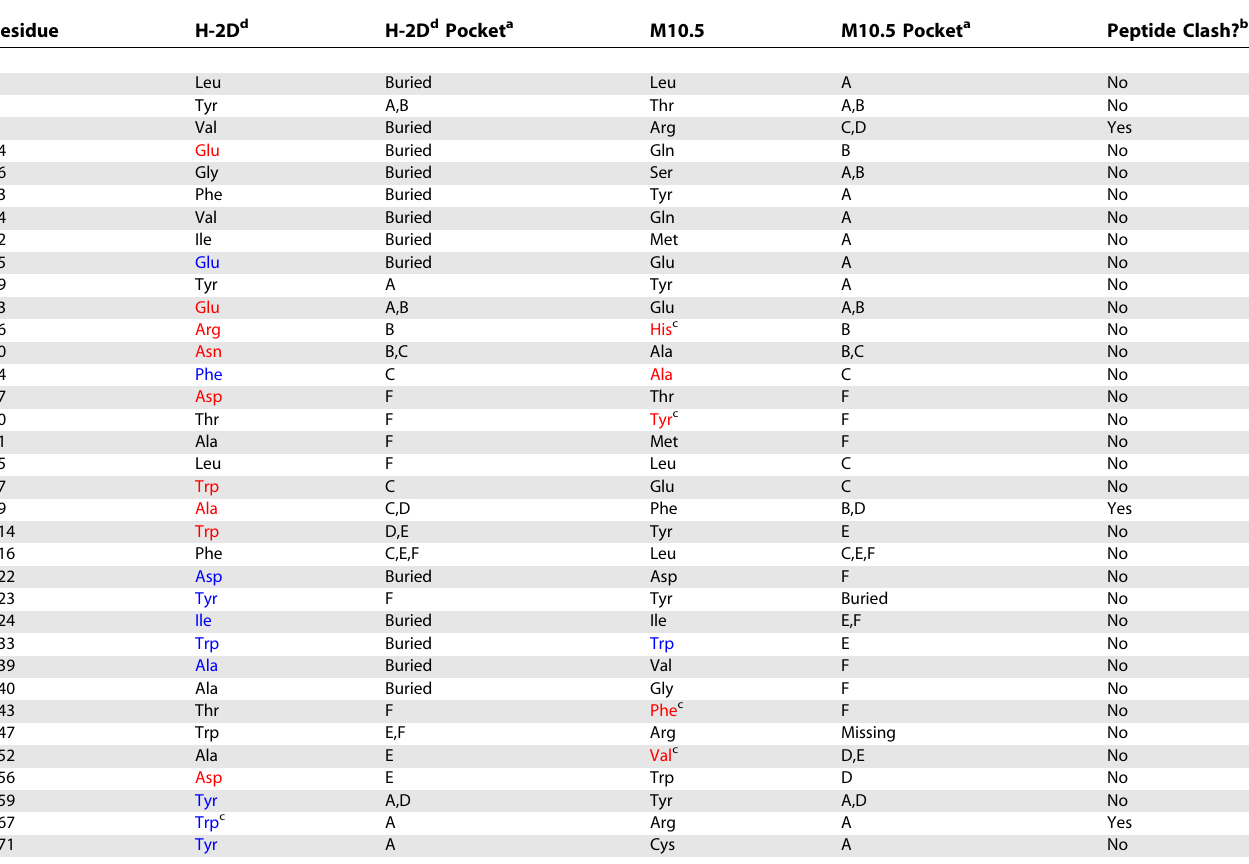
Conserved (blue) or highly variable (red) residues are defined as in Figure 4. a Grooveresidueshave5.0A˚ 2 ormoreofaccessiblesurfaceareatoa1.4A˚ radiusprobebutlessthan5.0A˚ 2 toa5.0A˚ radiusprobe. ‘‘ Buried ’’ residueshavelessthan5.0A˚ 2 ofaccessiblesurfaceareatoa1.4A˚ radiusprobe. ‘‘ Missing ’’ residues are disordered. b Residues with atoms less than 2.5 A˚ from a polyalanine version of an H-2D d –binding peptide superimposed in the M10.5 groove. c Residues that have accessible surface area in the groove but have more than 5.0 A˚ 2 of accessible surface area to a 5.0 A˚ radius